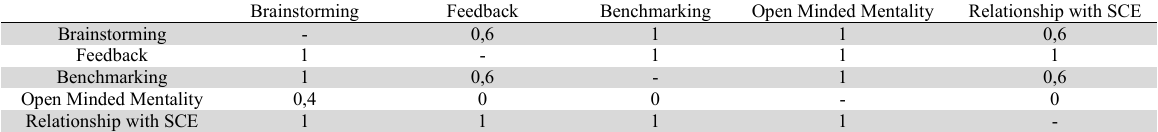
Cumulative concordance matrix